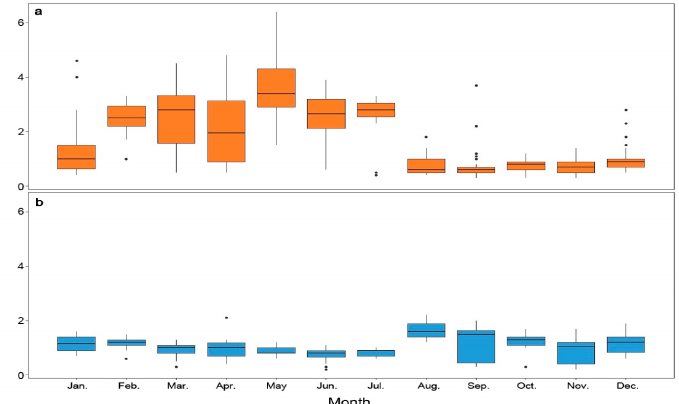
Figure 8. Monthly variation in the gonadosomatic index ( GSI ) of ( a ) female and ( b ) male specimens of Okamejei kenojei collected from January to December 2019 from the West Sea of South Korea.